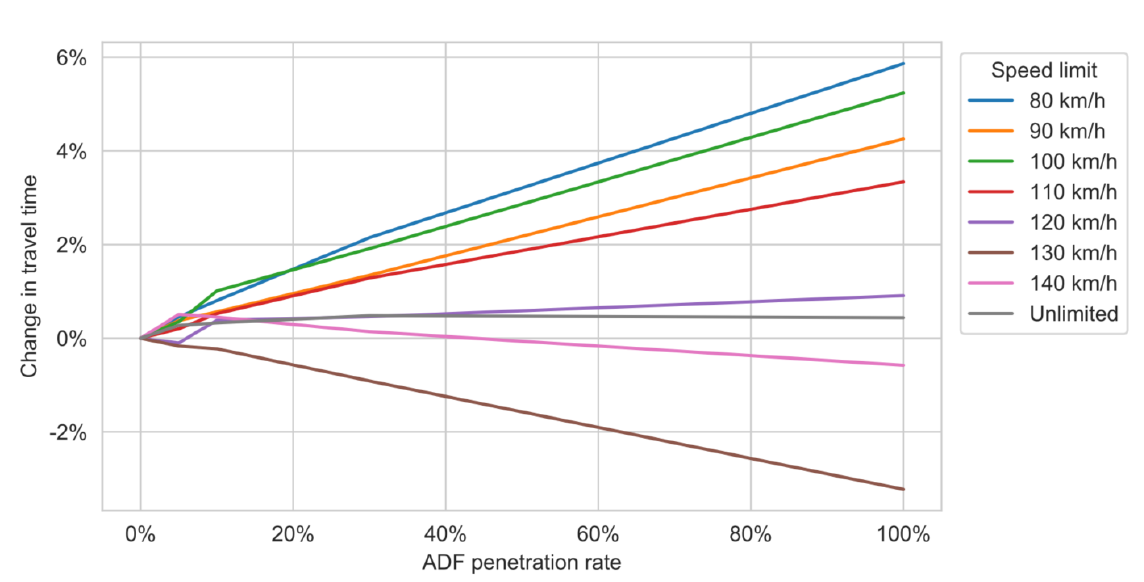
Figure 13. Scaled-up results with relative changes in travel time at AV penetration rates of 5%, 10%, 30% and 100% among passenger cars compared to the baseline at different speed